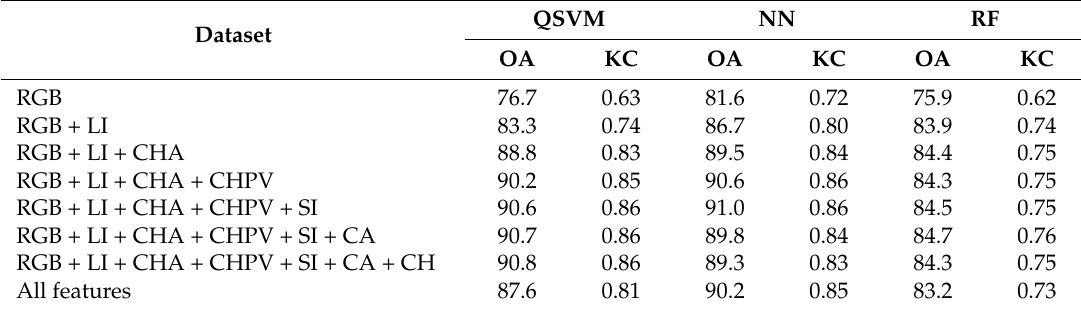
Table 5. Overall accuracy (%) and kappa coefficient of the QSVM, NN and RF classifications obtained using different tree features. OA, overall accuracy; KC, kappa coefficient. Other abbreviations are the same as in Tables 2 and